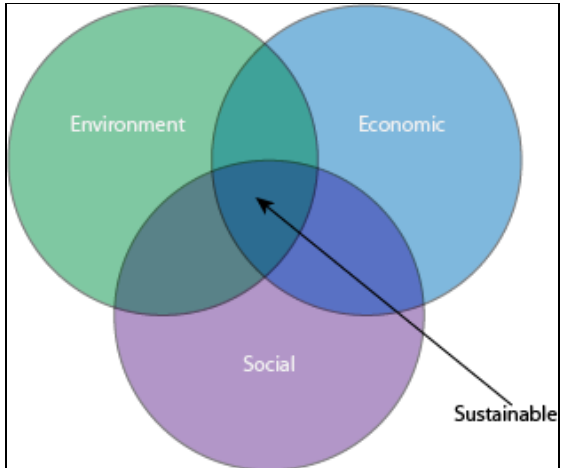
Figure 1. Three main aspects of